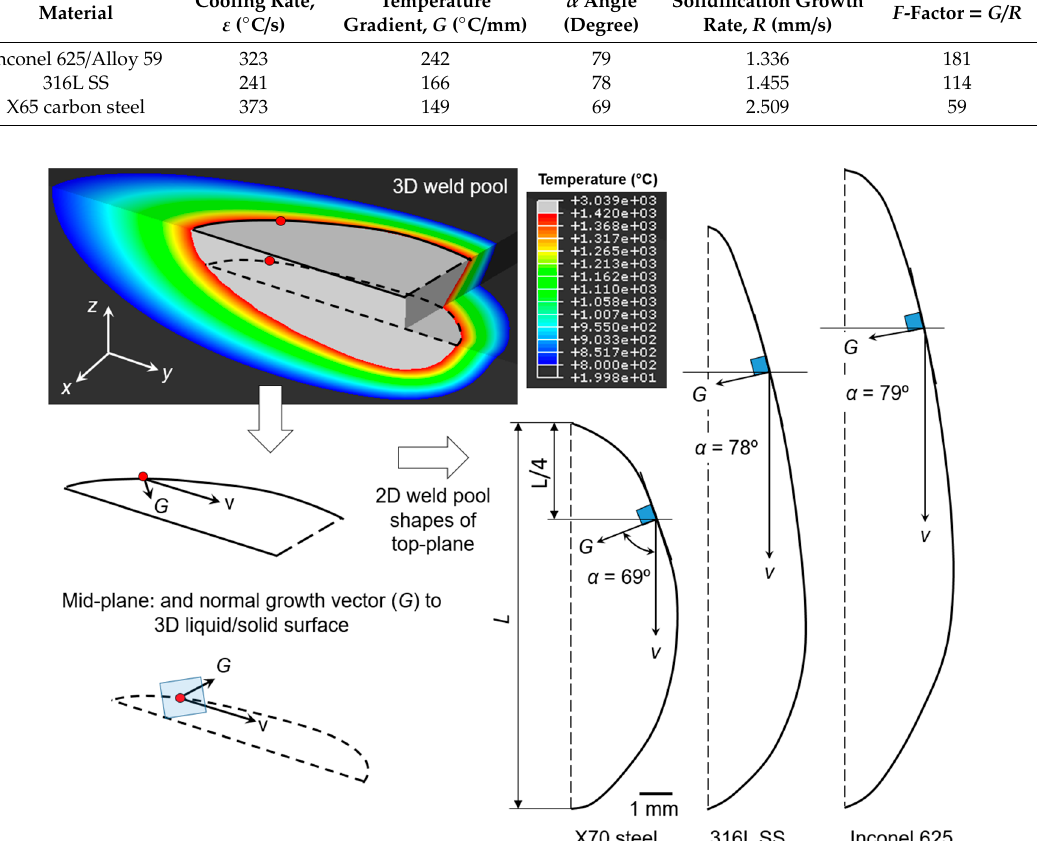
Figure 7. Numerically simulated weld pool profiles from a top-down view (middle plane) and identification of the solidification angle α at specific points.